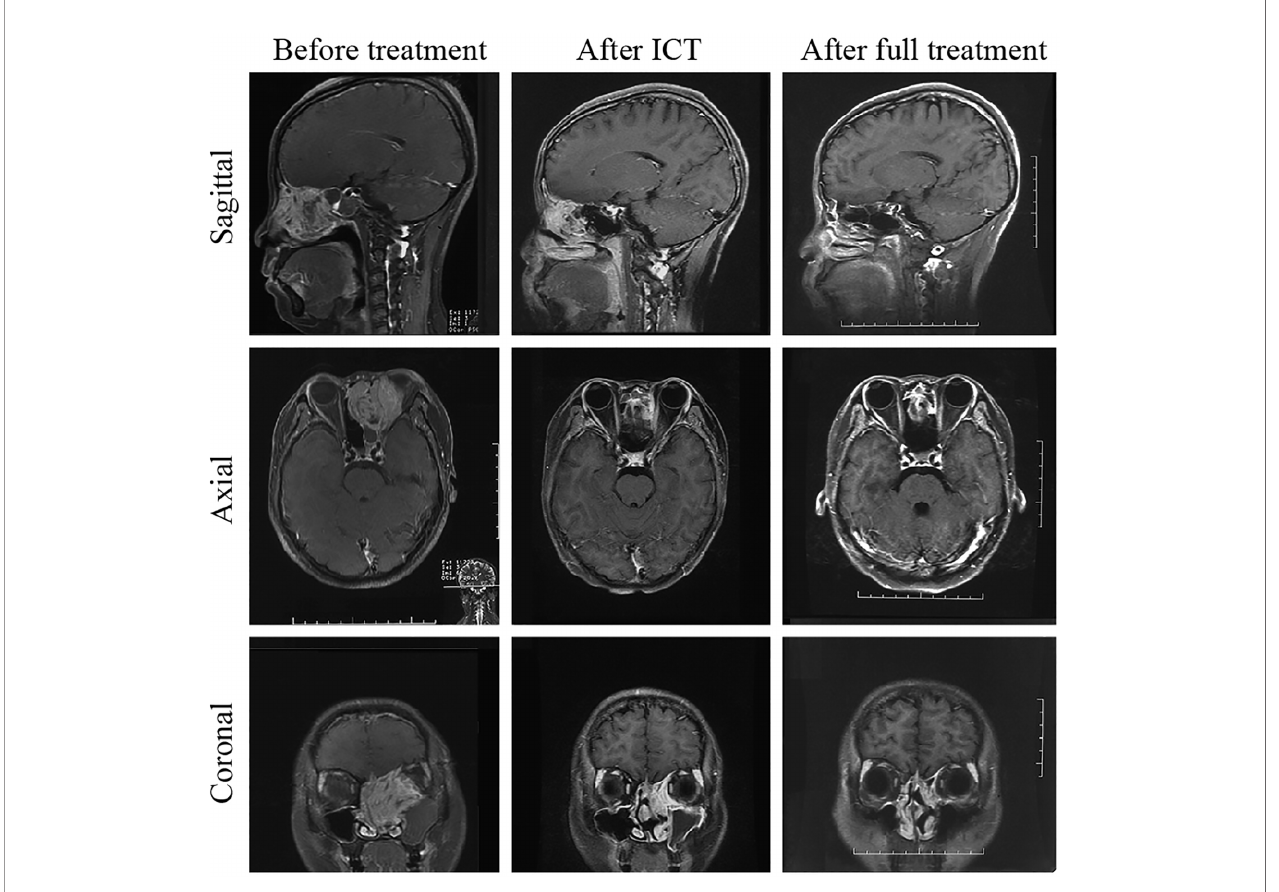
FIGURE 1 | Comparison of MRI before and after treatment of one patient with rhabdomyosarcoma. The lesion size was signi fi cantly reduced after ICT; 1 month after treatment, the tumor had completely subsided. The patient was followed up for 52 months and remained free of